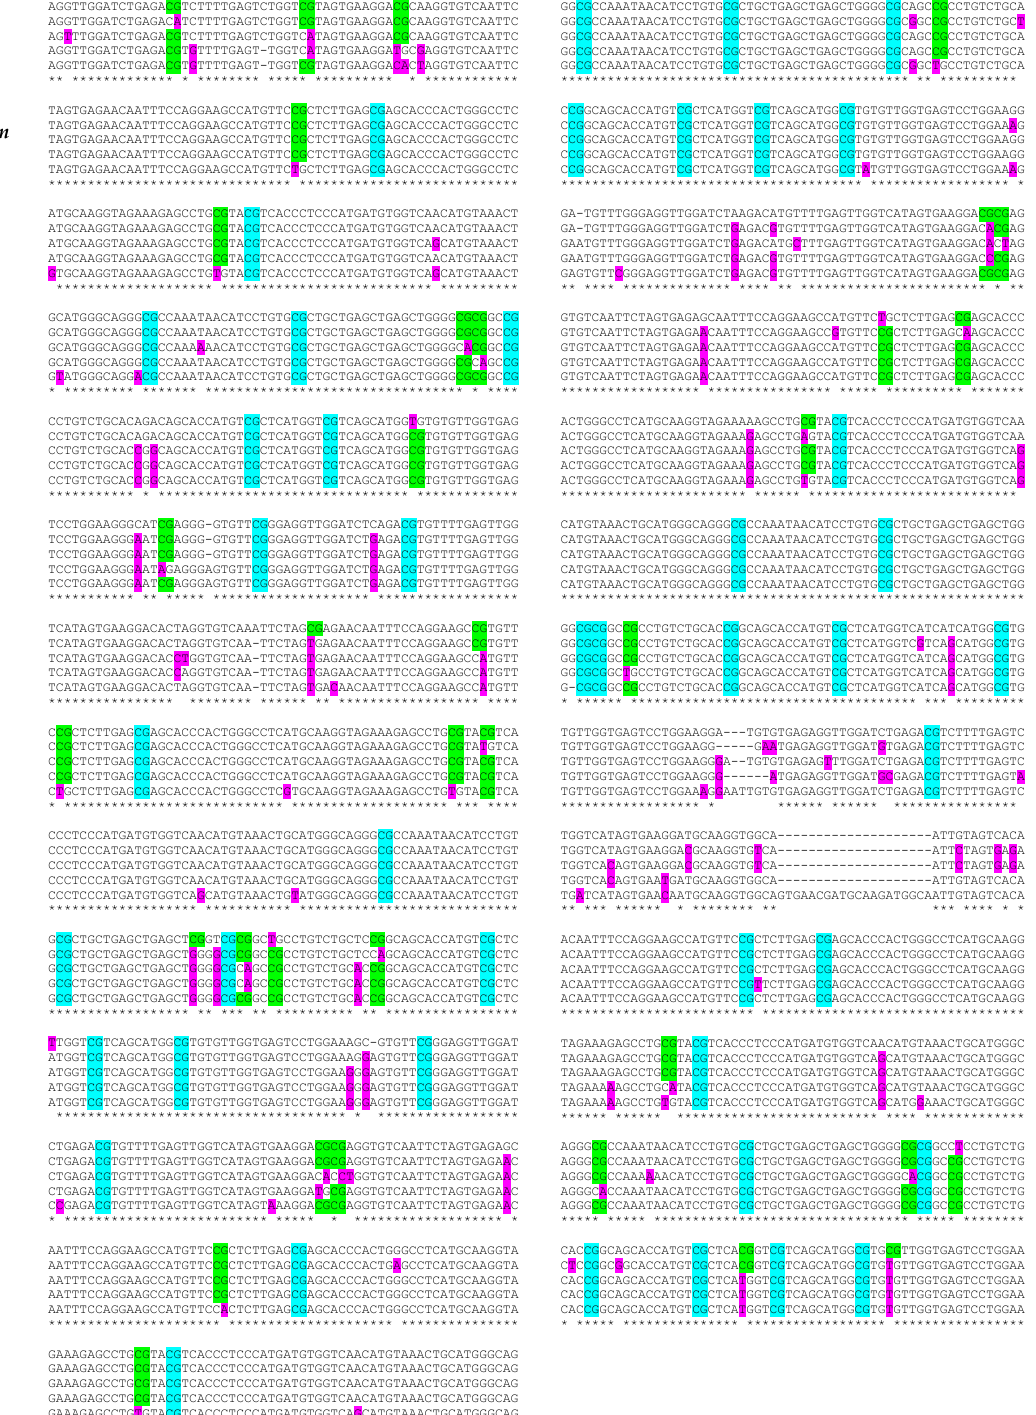
Figure 1. Alignment of assembled KIR promoter sequences in hominids. The CpG rich KIR gene promoter regions, each of 320 bp length, from the species human, gorilla, chimpanzee, bonobo and orangutan, have been strung together in the order KIR2DL3, KIR2DL1, KIR3DL1, KIR2DS4 and KIR3DL2 and have been aligned. All single nucleotide polymorphisms (SNPs) present in at least one of the five species are highlighted in purple (that is approx. 6.5%). All CpG dinucleotides largely preserved but affected by at least one nucleotide in at least one of the species are highlighted in green (approx. 44% of all preserved CpG positions). All CpG dinucleotides consistently preserved in all species are highlighted in light